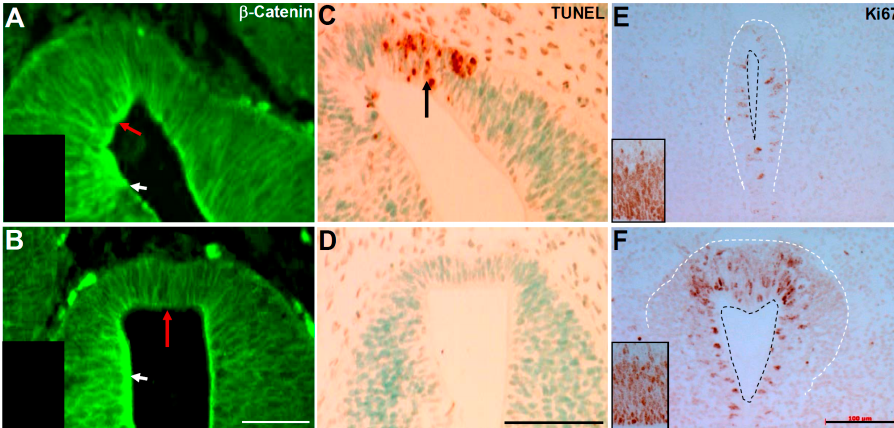
Figure 4. Marker analysis of anterior third ventricle morphogenesis. ( A , B ) Immunofluorescence detection of β -catenin expression in Pax3 flox { flox /Wnt1-Cre mutants ( A ) compared to control ( B ) E12.5 embryos. Red arrows point to the apical pole of the anterior side of third ventricles, revealing robust β -catenin in mutants but not control. However, β -Catenin expression is equally present in control and mutant lateral walls (white arrows). Inserts are negative controls, illustrating lack of autofluorescence; ( C , D ) TUNEL assay shows ectopic apoptosis in anterior wall of third ventricle in Pax3 flox { flox /Wnt1-Cre mutants (arrow, C ) but none in control; ( E , F ) Ki67 immunohistochemical analysis of reduced cell proliferation in Pax3 flox { flox /Wnt1-Cre mutants ( E ) compared to control ( F ) E12.5 embryos. Black dashed lines indicate the ventricular lumen and the white lines indicate the pseudostratified epithelium. Inserts from E12.5 lateral ventricles, exhibiting similar Ki67 labeling index in Pax3 flox { flox /Wnt1-Cre mutants ( E ) and control ( F ). Scale bars: A,B = 50 µ m; C–F = 100 µ